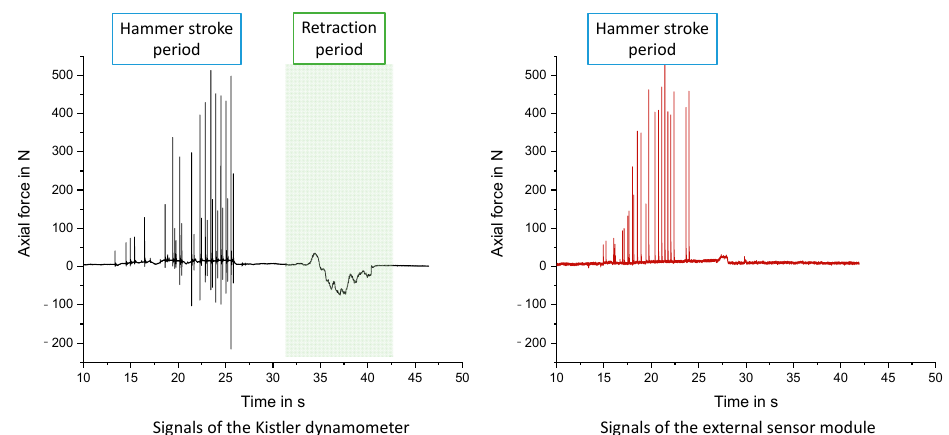
Figure 4. Comparison of the axial force measured with a high precision piezoelectric Kistler dynamometer and the self-developed external sensor module using a Shepard chisel.